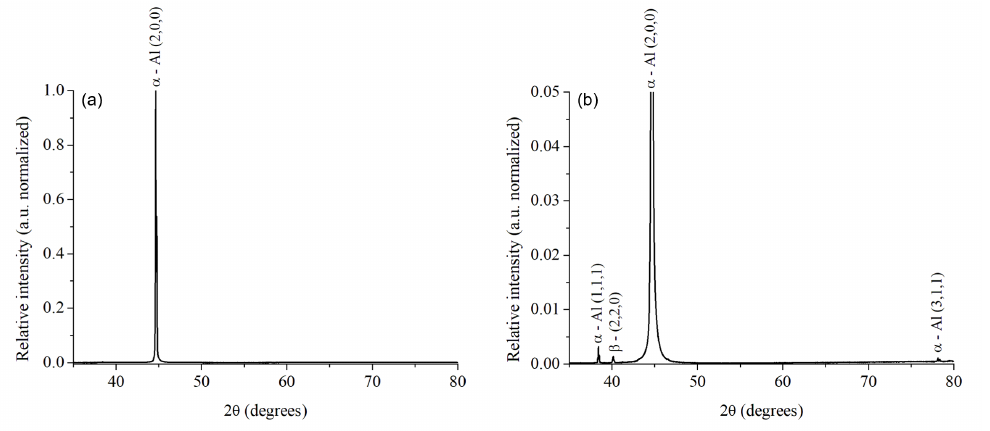
Figure 4. XRD spectra for AA6061–T6 (as-received) alloy at full-scale (normalized) ( a ), and the amplification of the trace peaks ( b ).